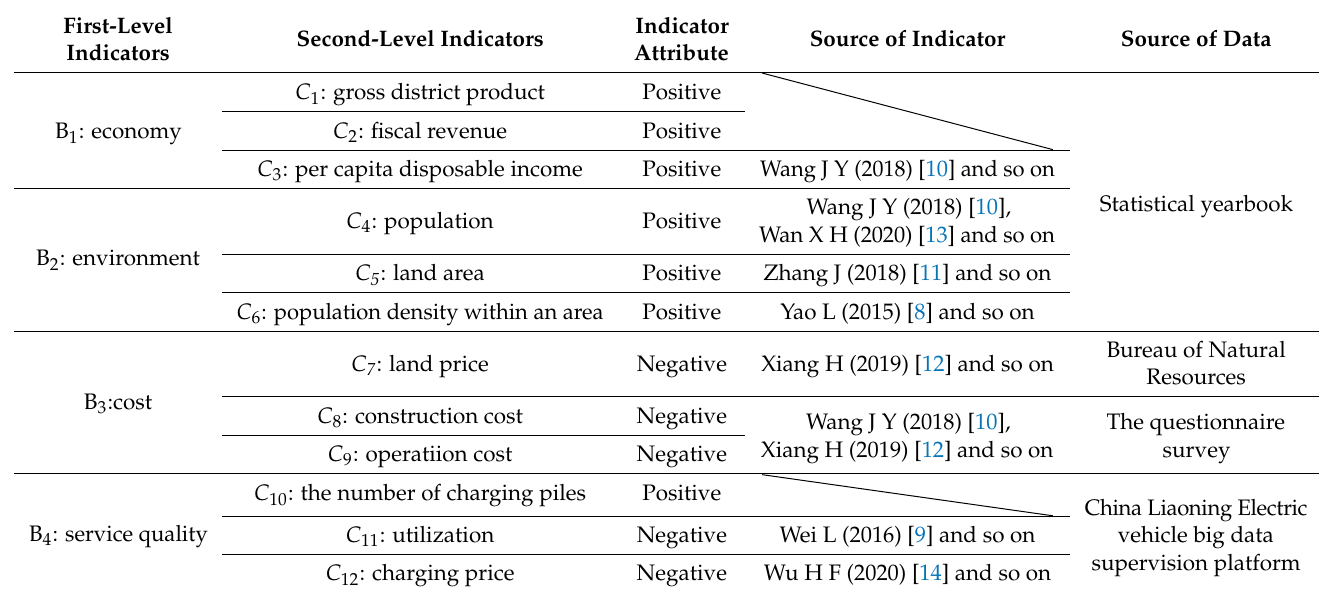
Table 1. The index system for evaluating the location of electric vehicle charging